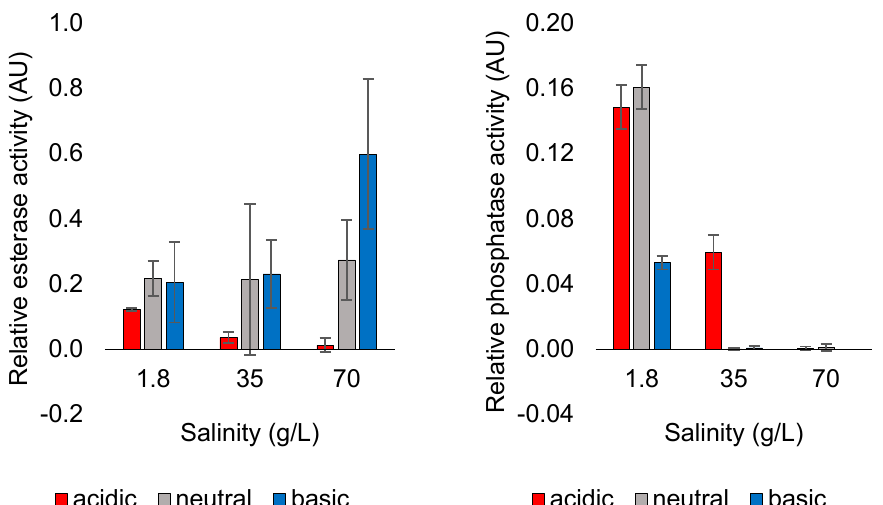
Figure 1. Evaluation of functional activity of evolved soups by pH and salinity. Left graph shows esterase activity; right graph shows phosphatase activity. Activity is reported as the absorbance (AU) at 405 nm as the formation of para-nitrophenol. Error bars are the standard deviation ( n = 3) from independently dehydrated/rehydrated samples from a single starting soup.